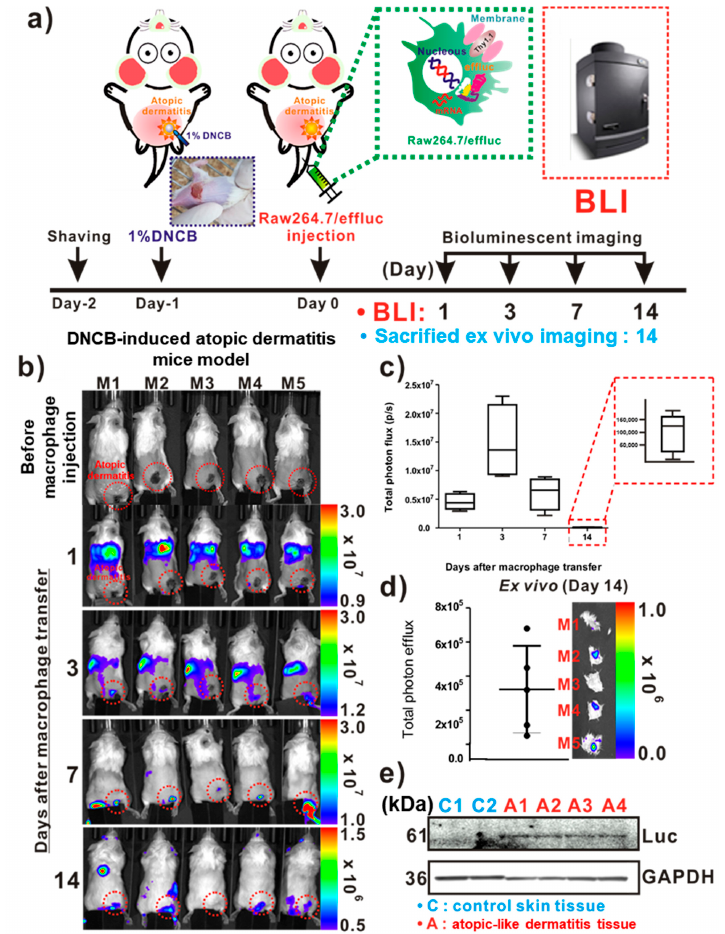
Figure 3. In vivo optical imaging of the macrophage infiltration of dinitrochlorobenzene (DNCB)- induced atopic dermatitis (AD). ( a ) Experimental procedures for in vivo animal experiments. ( b ) Visualization of the macrophage cell migration to DNCB-induced AD-like lesions. AD mice received reporter macrophage cells via intravenous injection, and their migration to the AD-like lesions was monitored at the indicated times. ( c ) Quantification of the bioluminescence imaging (BLI) signals in AD lesions at indicated times. Inset with square dotted lines shows the BLI signals in AD-like lesions on day 14. ( d ) Ex vivo BLI for the detection of infiltrated reporter macrophages in AD on day 14. ( e ) Immunoblot analysis in excised AD-like and control skins with anti-luciferase antibodies for evaluation of the presence of infiltrated reporter macrophages in AD-like lesions. Each group consisted of four mice, and experiments were performed at least in triplicate. The values indicate means ± SDs.